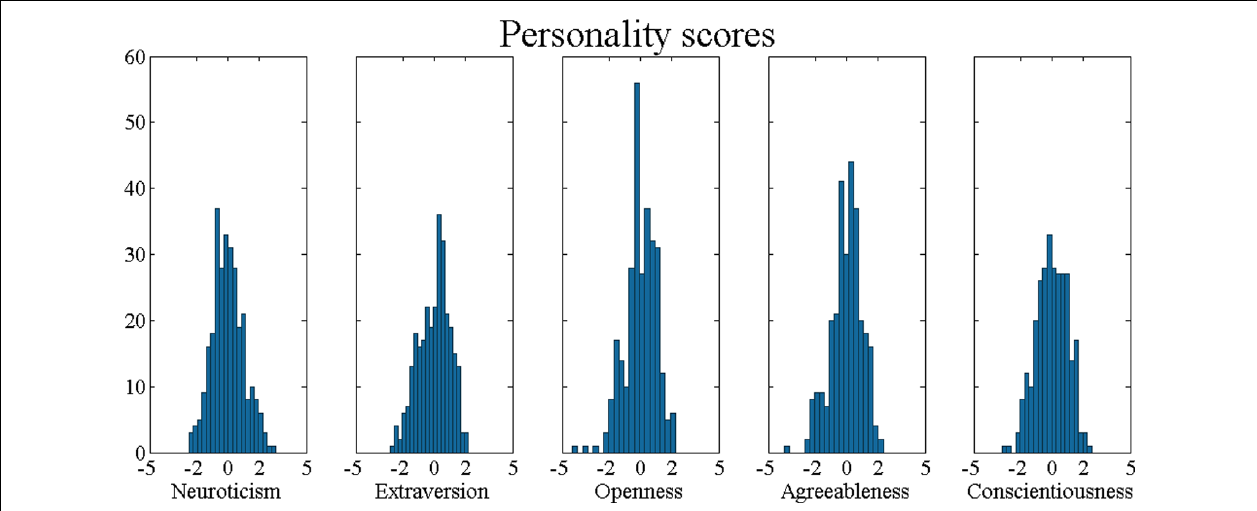
FIGURE 3 | Histograms of all five personality dimension scores. Note that the distributions are rather normal and personality scores are normalized by subtracting the mean and dividing by the SD.